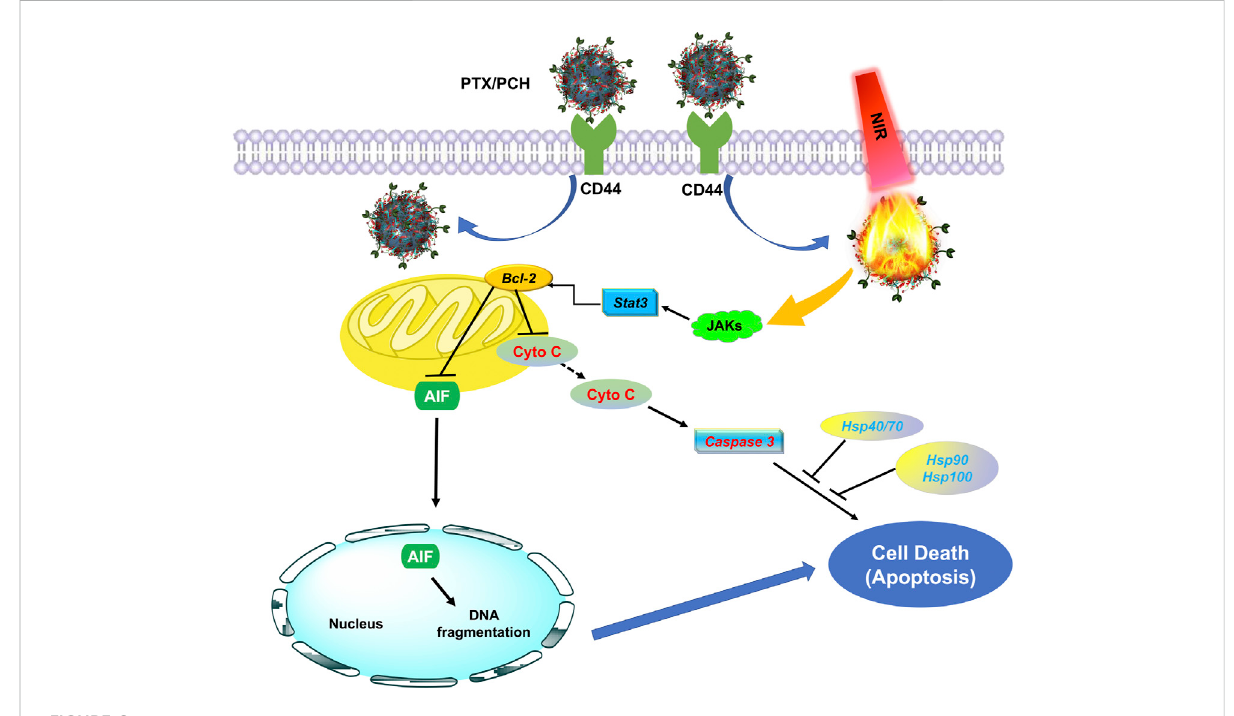
Schematic illustration for the mechanism of PTX/PCH + NIRs induced